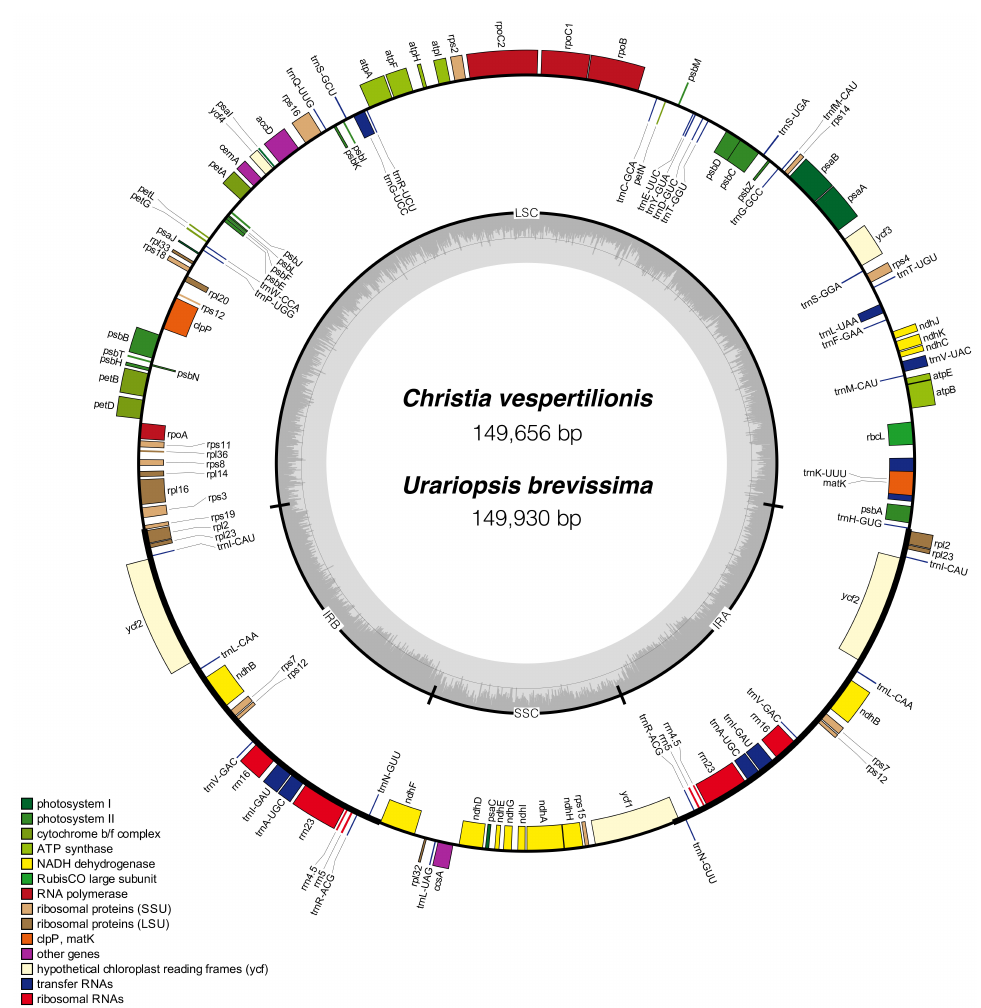
Figure 1. Gene maps of Christia vespertilionis and Urariopsis brevissima chloroplast genomes. Genes drawn outside the circle are transcribed counterclockwise, and those inside the circle are transcribed clockwise. Genes of di ff erent functions are color-coded. The dark gray area in the inner circle corresponds to the GC content of the corresponding genes, and the light gray area corresponds to the AT